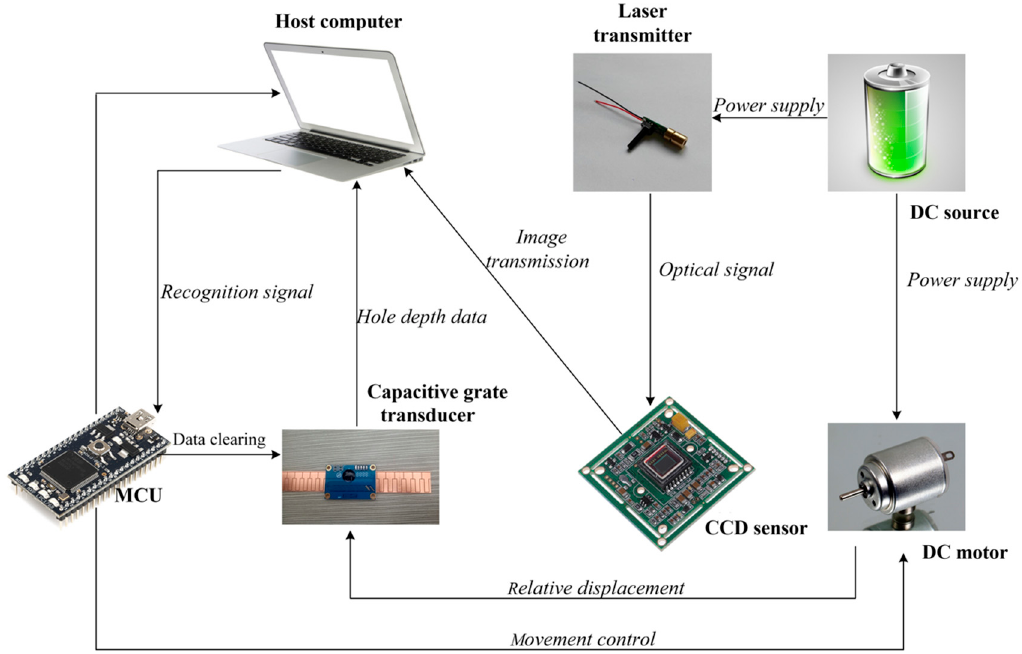
Figure 6. Hardware connection diagram of the measurement system; DC: direct current